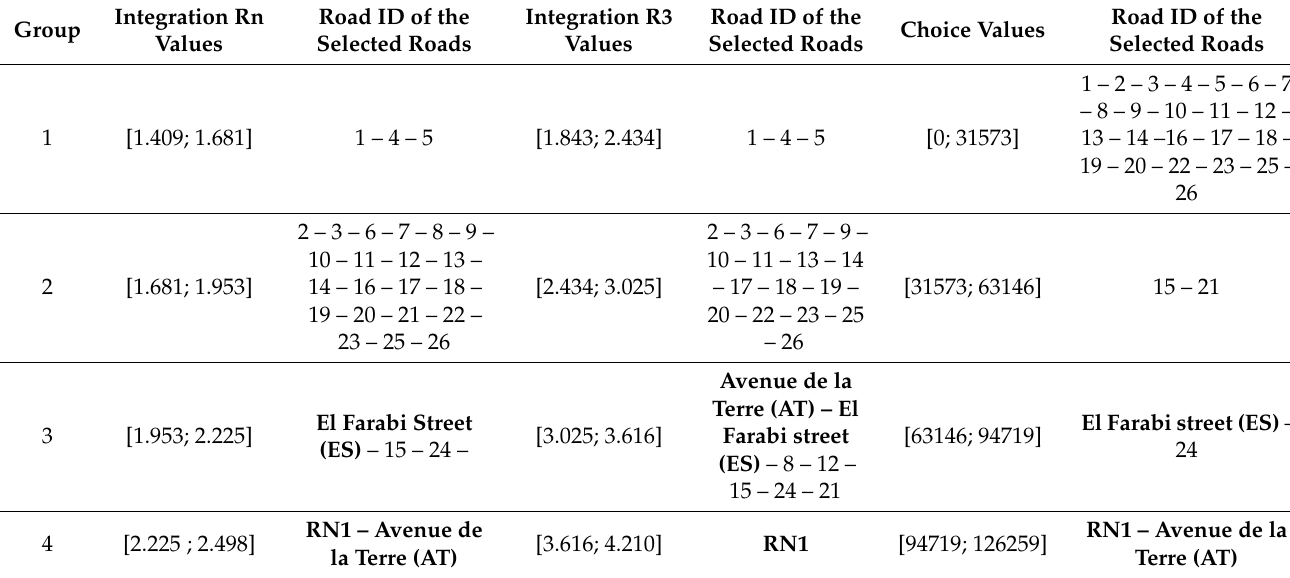
Table 1. Bir El Bey roads categories as a function of Integration Rn, Integration R3, and Choice values.